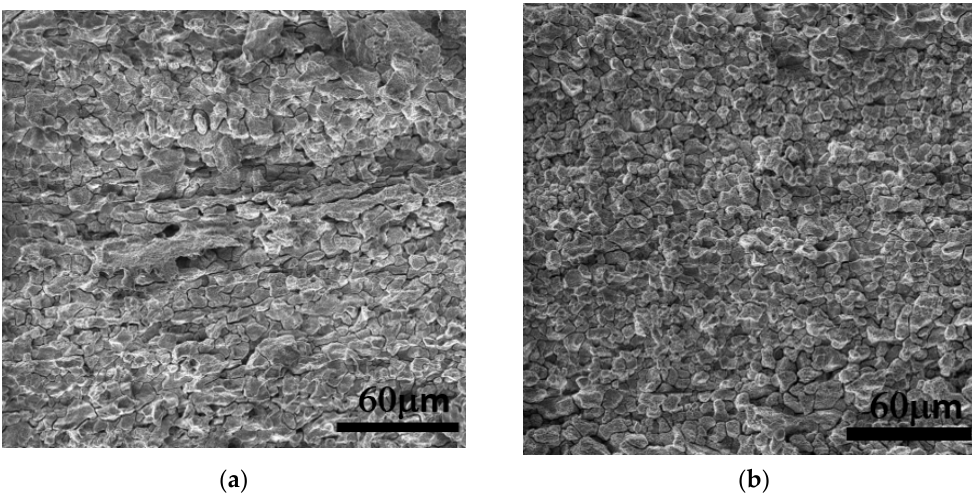
Figure 9. SEM morphology of alloy corrosion after sensitization: ( a ) alloy C annealed at 350 °C; ( b ) alloy C annealed at 450 °C.